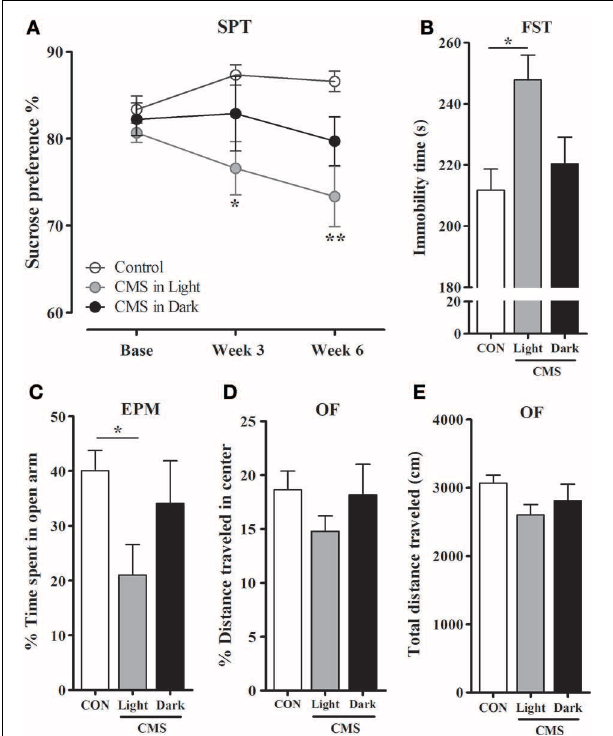
FIGURE 3 | Emotional behavior in rats exposed to CMS in different diurnal phases. (A) Preference changes of sucrose consumption in the Sucrose preference test (SPT). ∗ indicates a significant difference between the CMS-Light and CON. There were no significant differences between the CMS-Dark and the two other groups. (B) Forced swimming test (FST). Immobility time during the test period. (C) Elevated plus maze (EPM). Percentage of time spent in the open arms (D–E) Open field test (OF). (D) Percentage of the distance traveled in the center and (E) Total distance traveled in the OF apparatus. Controls, n = 20, each CMS group, n = 14; ∗ P < 0 . 05; ∗∗ P < 0 . 01. Data presented as mean ± s.e.m.